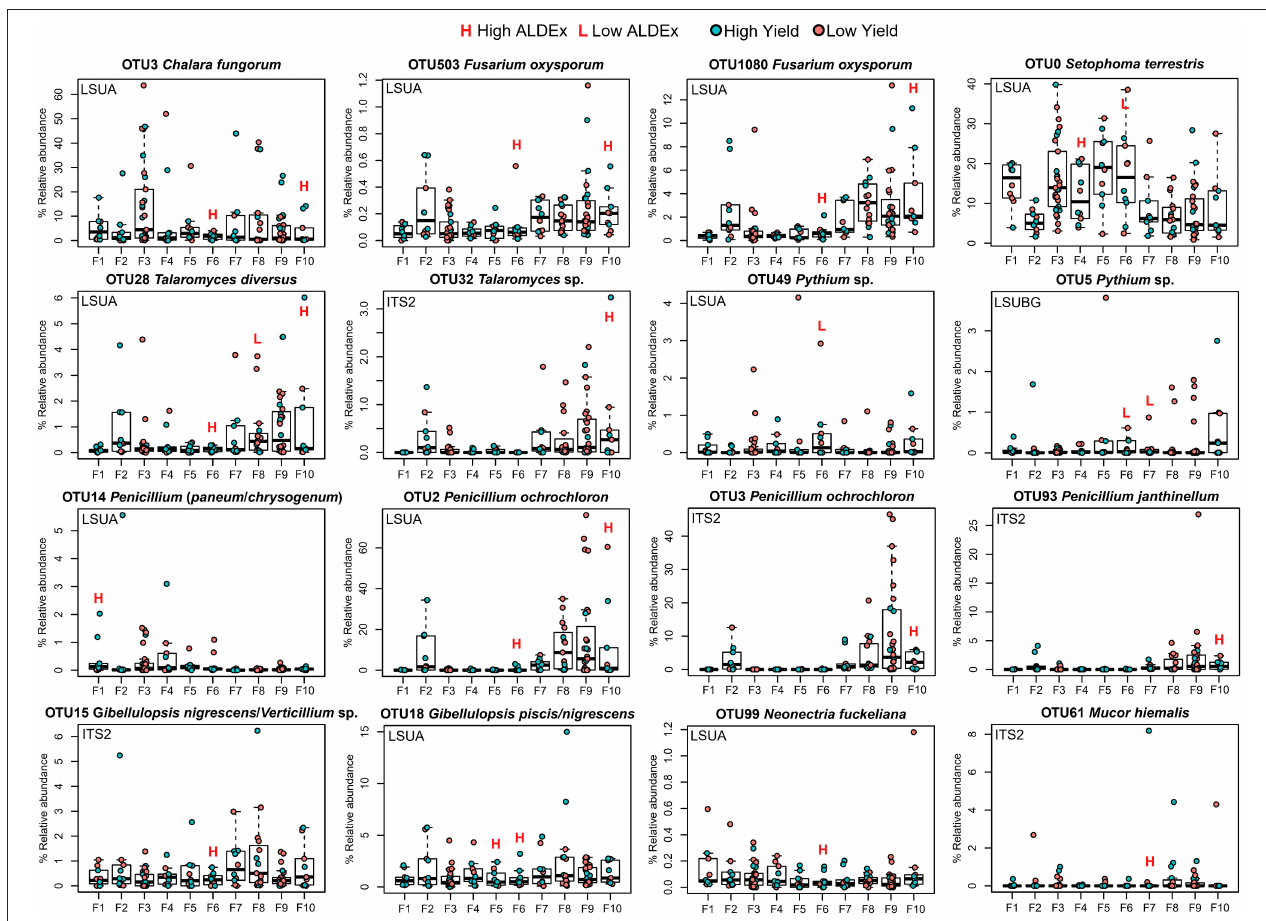
FIGURE 7 | Relative abundance (%) boxplots of significant ALDEx OTUs. Points are colored by site yield (low or high). Outliers are shown beside y-axis values. ALDEx significance (large effect sizes; − 1.0 > x > 1) is shown using L/H lettering above corresponding